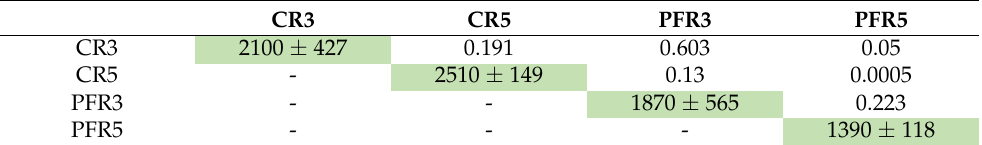
Table 2. Comparison of abundance-based estimator of OUT richness according to Chao1 index in different samples of calyx-end and peel tissues derived from bagged (i.e., CR5 and PFR5) and unbagged (i.e., CR3 and PFR3) fruit. Green boxes contain the values of mean and standard deviation determined for each apple part. White boxes contain p -values of the results of pairwise comparisons using the Student t -test. CR3 CR5 PFR3 PFR5